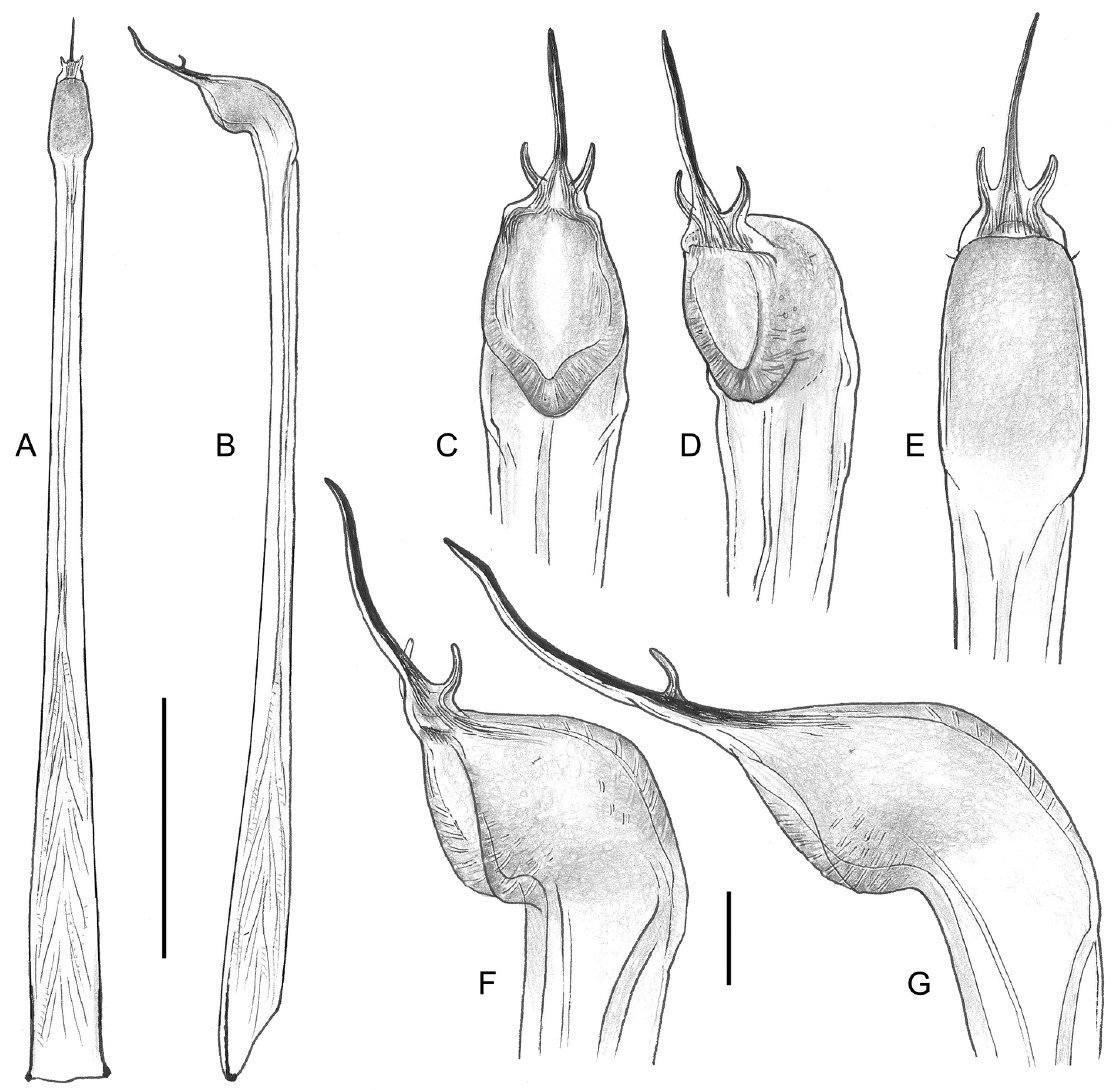
Fig. 12. Dicranopalpus cantabricus Dresco, 1953 (ZUPV 4542). Penis. A . Ventral view. B . Lateral view. C – G . Glans. C . Dorsal view. D . Slightly dorsolateral view. E . Ventral view. F . Dorsolateral view. G . Lateral view. Scale bars: A–B = 0.5 mm; C–G = 50